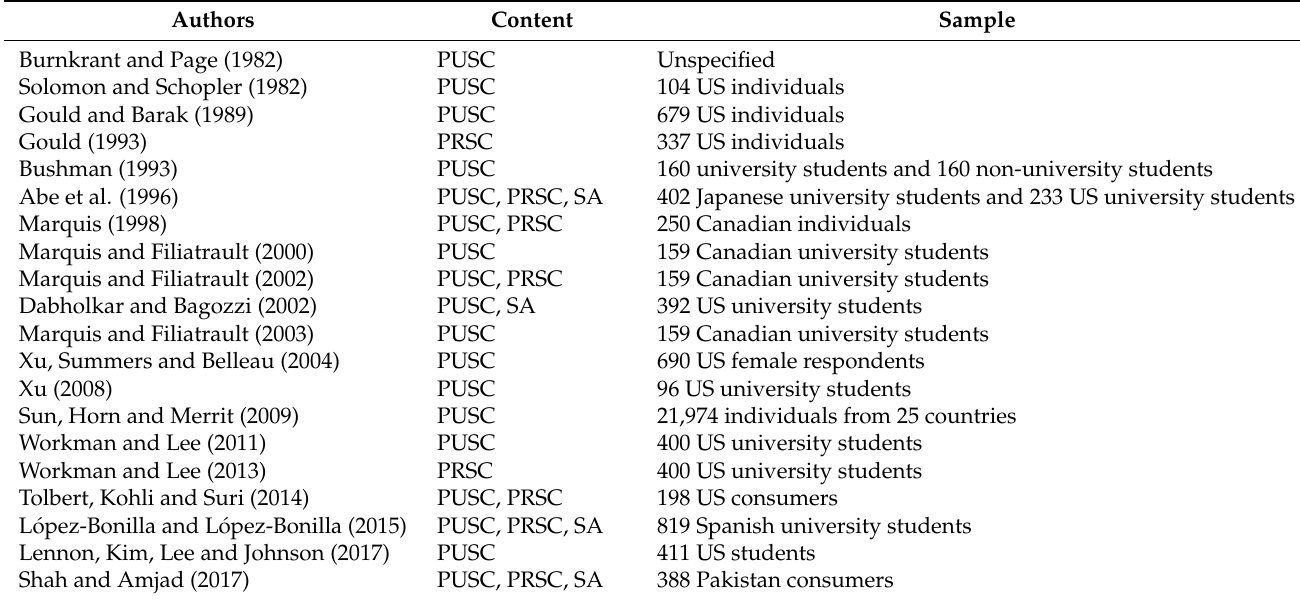
Table 1. Self-consciousness research on consumer